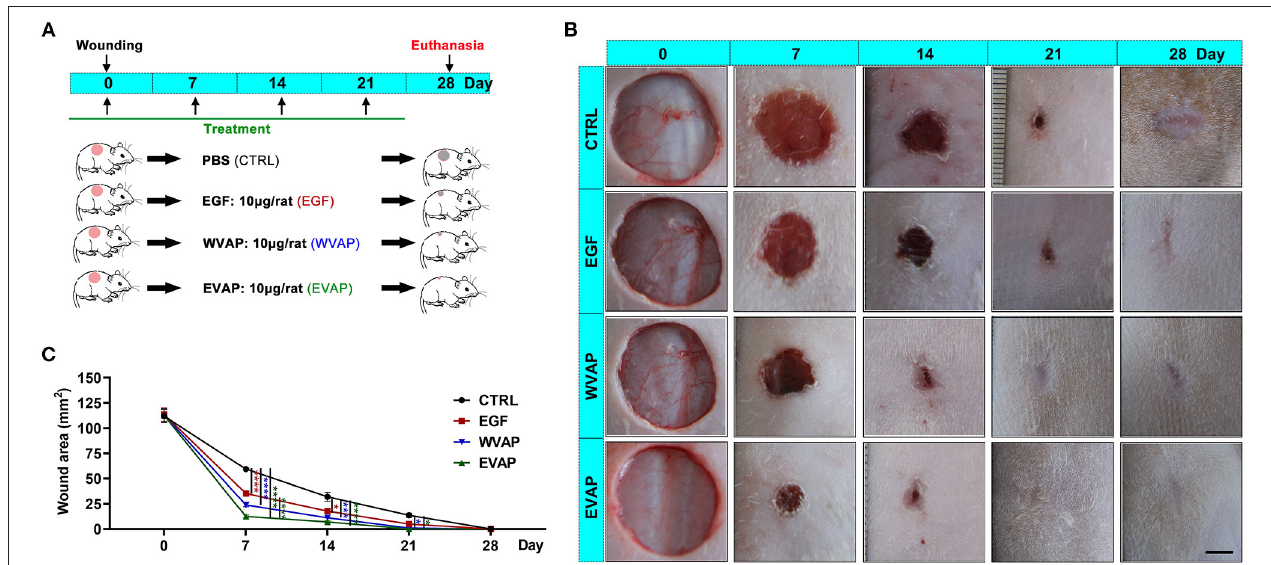
FIGURE 2 | Effects of EVAP on healing rate of the full-thickness skin wound in rats. (A) Schematic drawing of experimental design. The dorsal hair was shaved, and then full-thickness skin wounds (diameter = 12mm) were created on the shaved skin. EVAP solution was administered via both local injection surrounding each wound and topical application over the wound once every 7 days for 28 days. PBS, EGF, or WVAP served as controls. (B) Morphological changes of the wounds during the healing period; scale bar = 5mm. (C) Quantitative evaluation of changes in wound area during the healing period. Note that the fastest wound healing rate and the smallest wound area occurred in the EVAP group compared to the control groups. * P < 0.05; *** P < 0.001; **** P < 0.0001; mean ± SD; n = 7. CTRL, control; EGF, epidermal growth factor; EVAP, enzymatically-digested velvet antler peptides; WVAP, water velvet antler peptides.